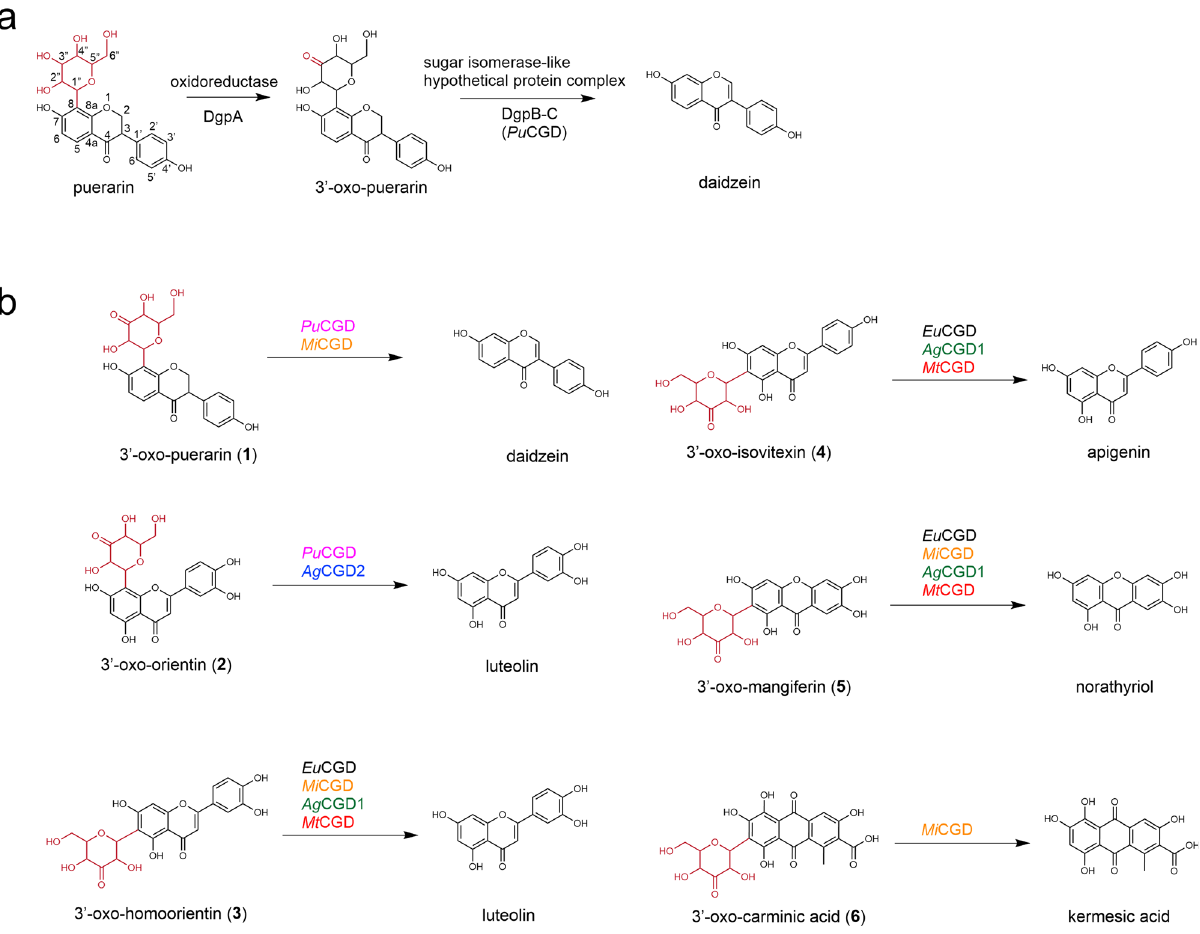
Fig. 1 Reactions of C -deglycosylation enzymes. a Two-step C-C bond cleavage reaction by oxidoreductase (DgpA) and C -deglycosylation enzymes (DgpC and DgpB; Pu CGD). b C -deglycosylation enzymes used in our studies: Pu CGD, Eu CGD, Mi CGD, Ag CGD1, Ag CGD2, and Mt CGD. Sugar moieties are shown in red. The substrates investigated in this study were C8-glycosylated fl avonoids 1 and 2 , C6-glycosylated fl avonoids 3 and 4 , C-glycosylated xanthonoid 5, and C-glycosylated anthraquinone 6